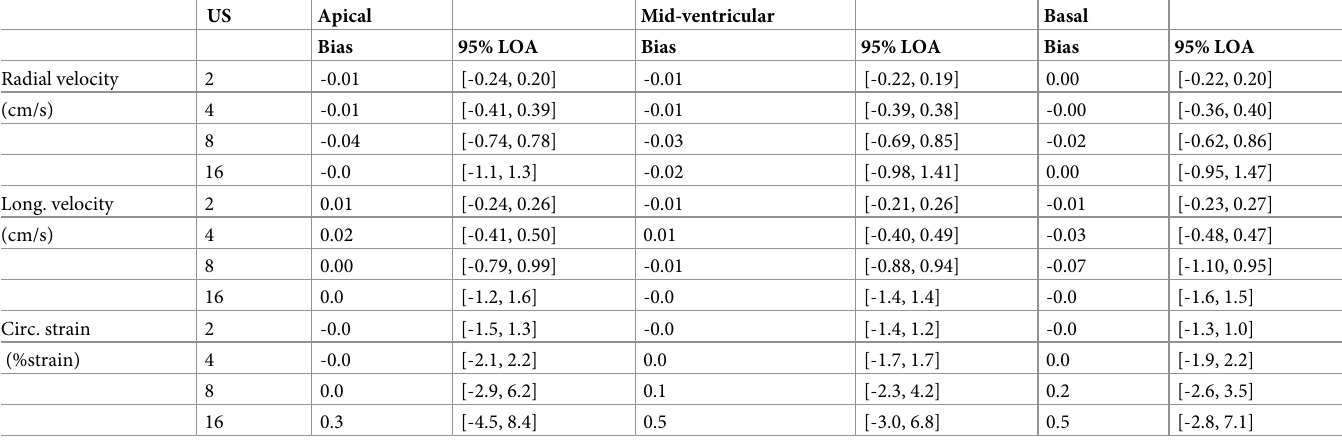
Circumferential strain was calculated from temporal integration of the myocardial velocity field measured by TPM [5,20]. US = undersampling factor. LOA = limits of